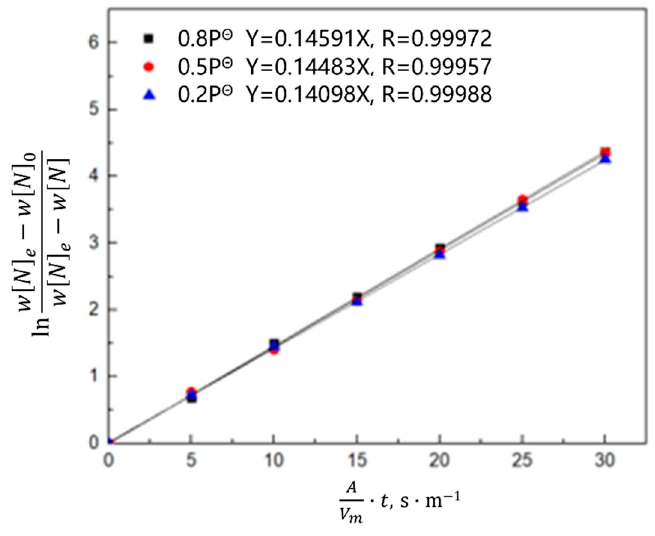
Figure 10. Kinetics of the nitrogen amount in the molten steel under different nitrogen partial pressures.